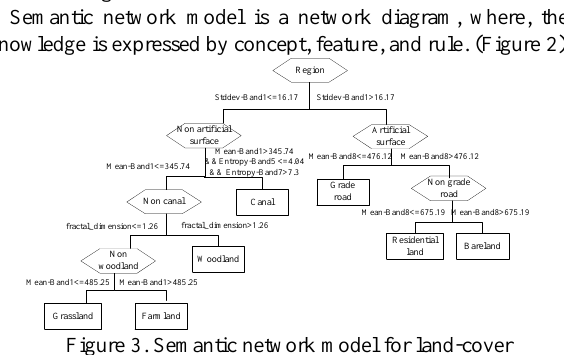
Figure 3. Semantic network model for land-cover Nodes represent a variety of things, concepts, condition, attributes, actions, status; Arcs represent various semantic relationships between nodes; the nodes and connections with the logo used to distinguish various relationships between different objects.